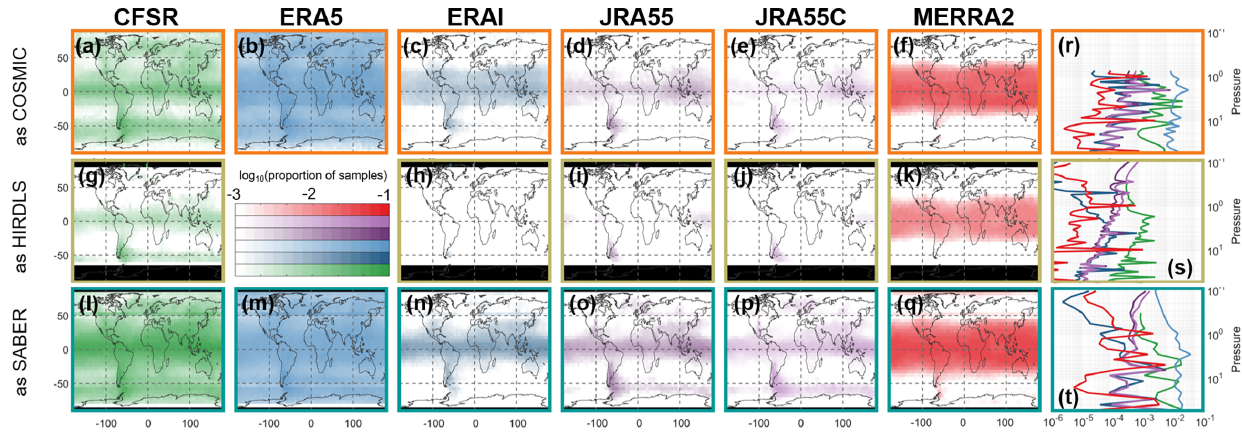
Figure C3. Geographic variability in (cid:49)T SPA . The leftmost six columns show maps of the column-integrated proportion of samples with (cid:49)T SPA > 0 . 5K on a 2.5 ◦ grid, while the rightmost column shows the globally integrated samples with (cid:49)T SPA > 0 . 5K at each height. Colour bars are the base-10 logarithm of the proportion of samples. Black regions on maps indicate a lack of